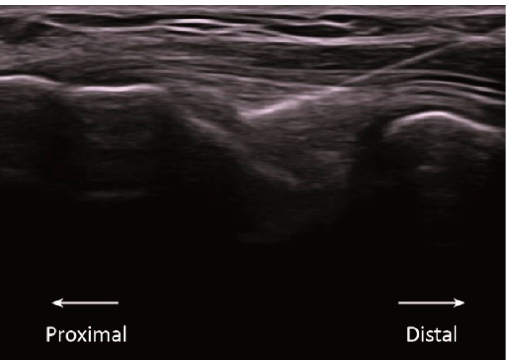
Figure 1. Ultrasound imaging of the application of percutaneous electrolysis in the common extensor tendon of the lateral epicondyle.